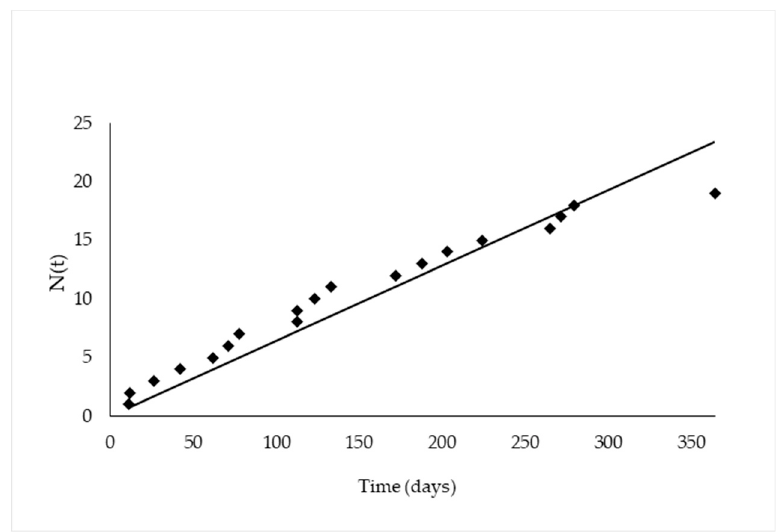
Figure 7. GT ― Anomalies type occurrences. Figure 7. GT—Anomalies type